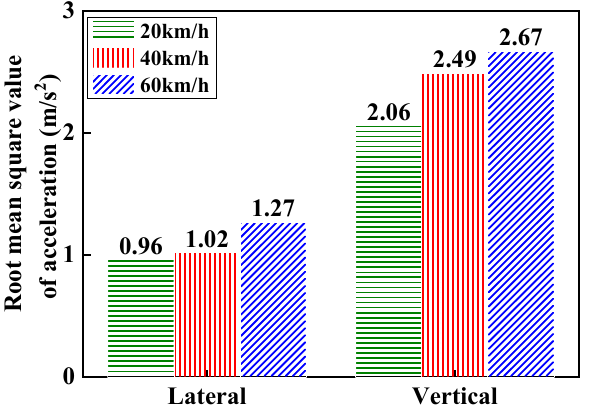
Figure 8. Time domain and frequency domain of vibration acceleration at 60 km/h maglev train speed: ( a ) lateral and ( b ) vertical.